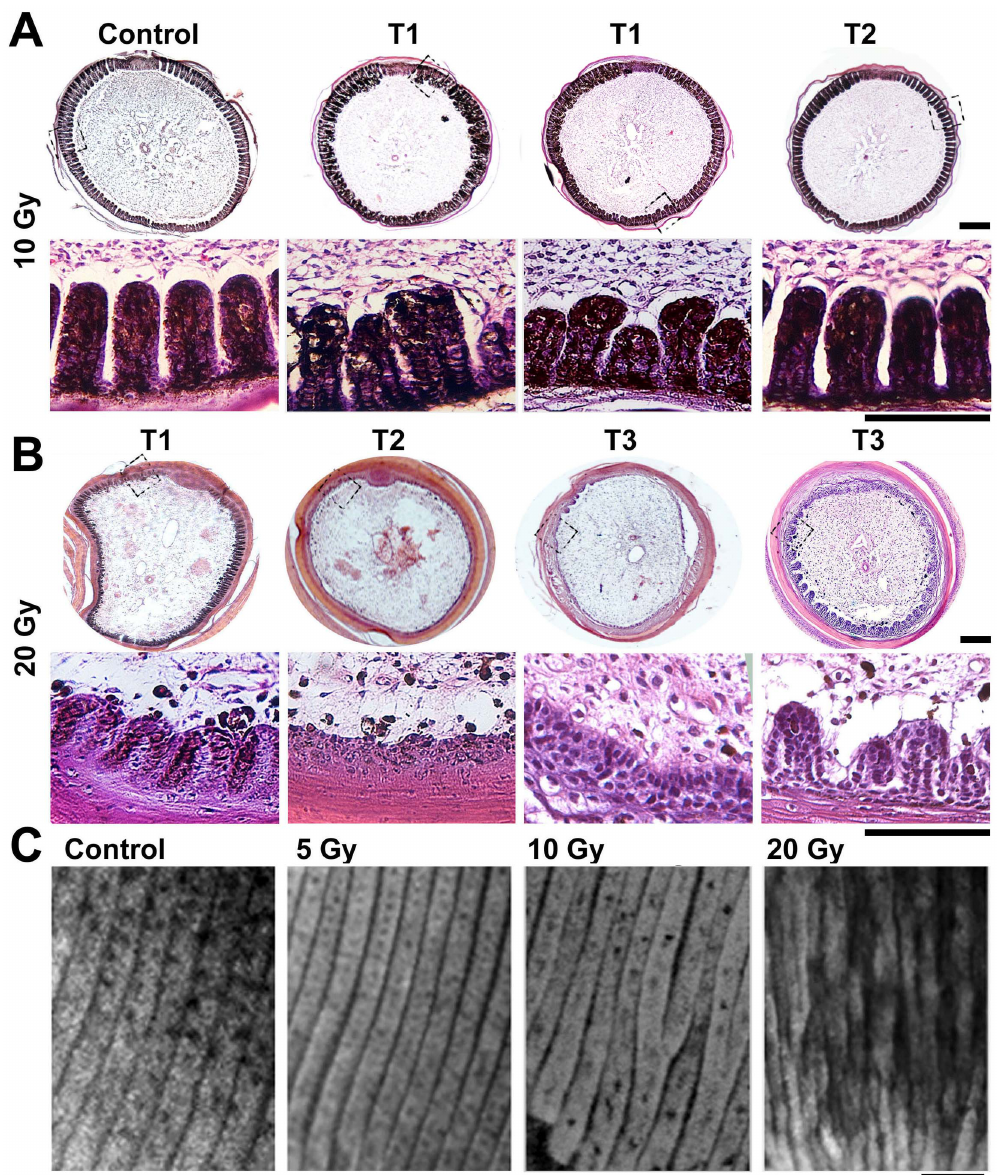
Figure 2. Analysis of IR-induced defects in feather formation. (A–B) H&E analysis of feather follicles after IR-exposure at different doses. At 10 Gy, the total epithelial cell number remains unchanged, yet extensive branching abnormality is seen. This is transient and reversible; at T2 (2 days post-IR) the feathers become normal again. At 20 Gy, the feather epithelium is significantly reduced. Heterogeneity in T3 (3 days post-IR) is noticed, with some recovered little while others showed branching epithelium again. Representative examples of 8 follicles examined in each case are shown. (C) Whole-mount prep of feather epithelial branching at T1 (1 day post-IR) showing the disrupted patterning at 10 or 20 Gy. Bar=100 m m.